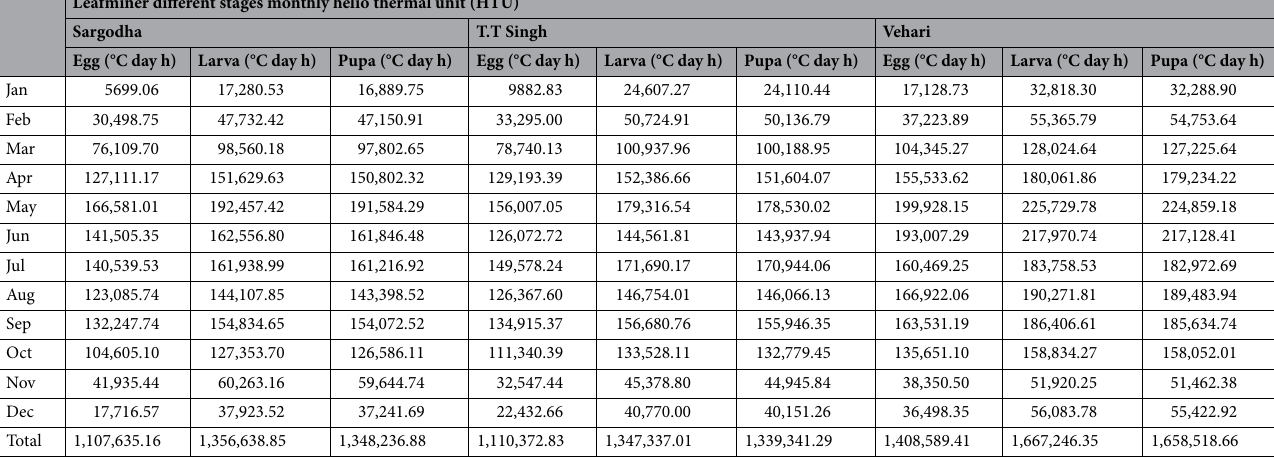
Table 6. Leafminer helio thermal units